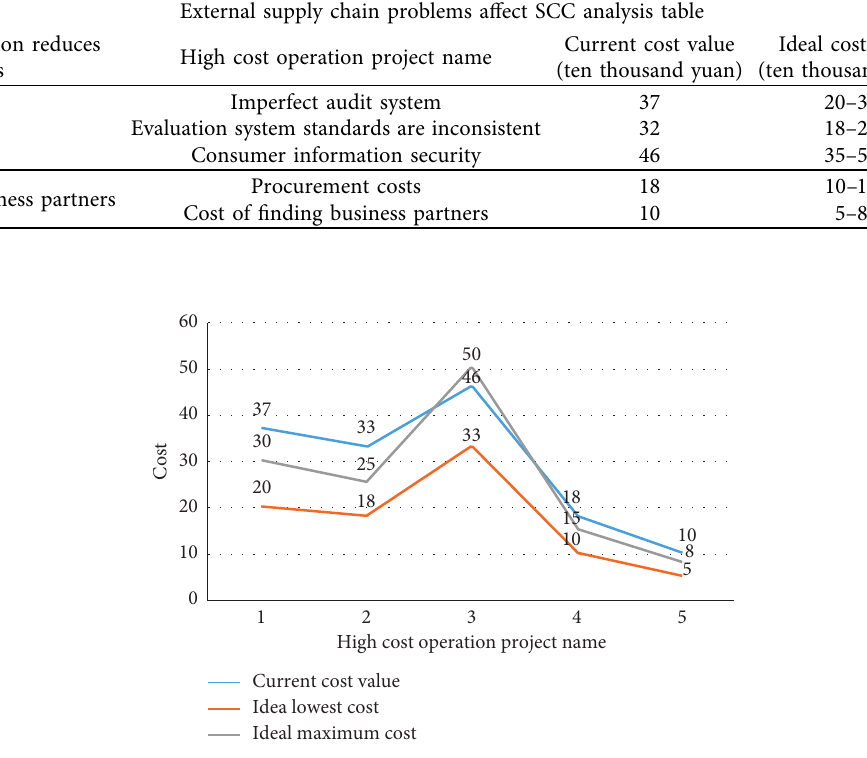
Figure 1: Cost analysis table of external supply chain problems affecting supply